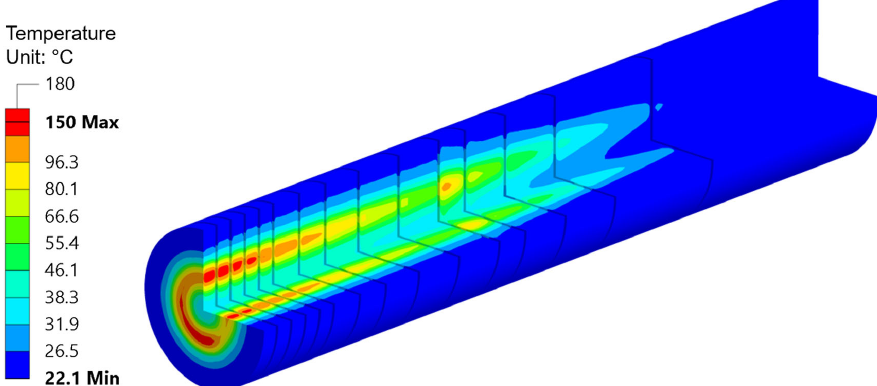
FIG. 3. Temperature distribution in the BDF target at the end of the one second long spill. The effect of the BDF beam dilution system can be clearly appreciated: four beam sweep turns in one second over a 50 mm radius circular pattern.